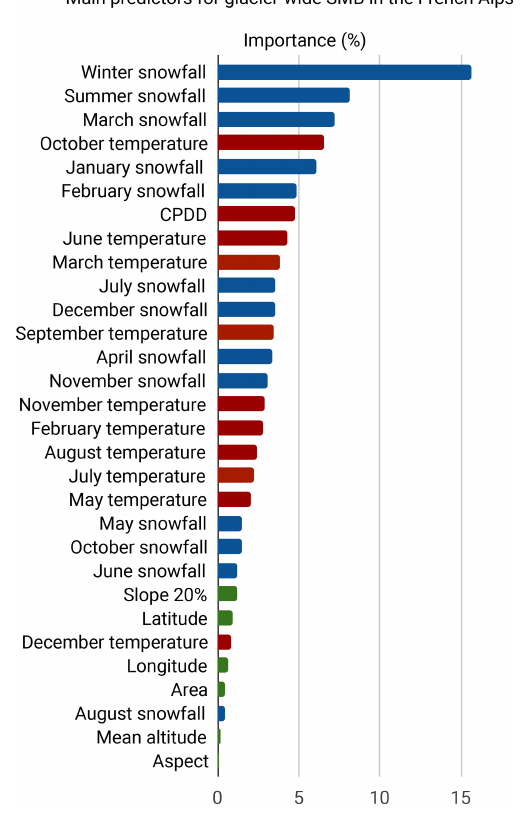
Figure 5. Contribution to the total variance in the 30 top topo- climatic predictors out of 55 predictors using Lasso. Green bars indicate predictors including topographical features, blue ones in- clude accumulation-related features and red ones include ablation- related